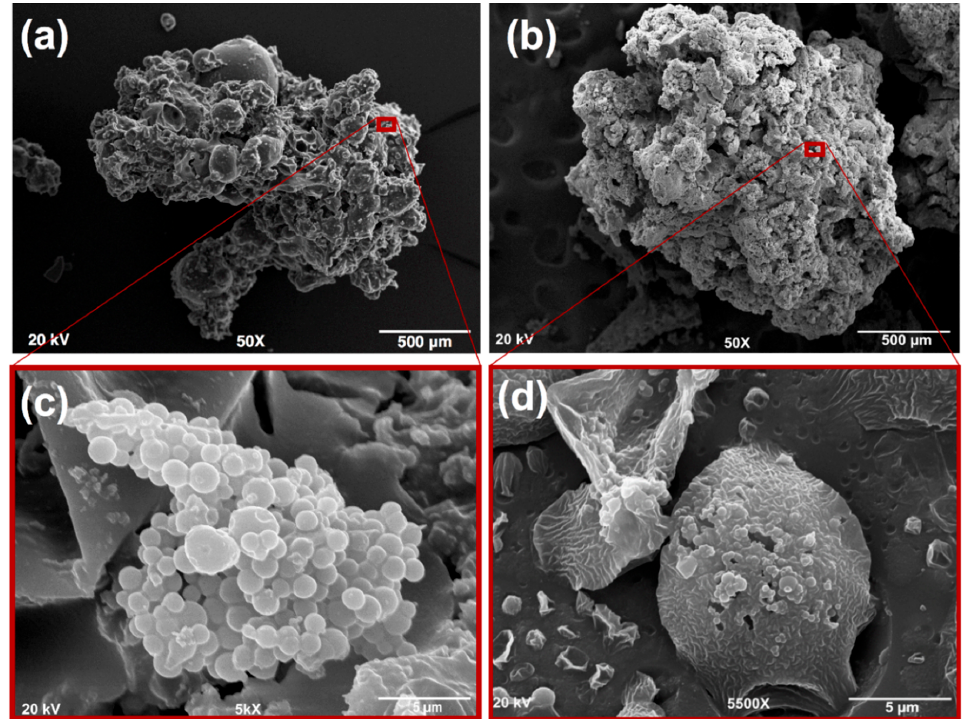
Figure 1. SEM images of representative poly(dimethylsiloxane) (PDMS) beads with ( a ) no TiO 2 and ( b ) with a mass ratio of 20% TiO 2 added to the emulsion. Red rectangles indicate the areas in which images of the magnified regions for ( c ) the inert PDMS bead and ( d ) the 20% TiO 2 /PDMS bead were measured. The convex porosity of the beads increases the surface area per bead, allowing a high density of available TiO 2 for photocatalytic degradation.